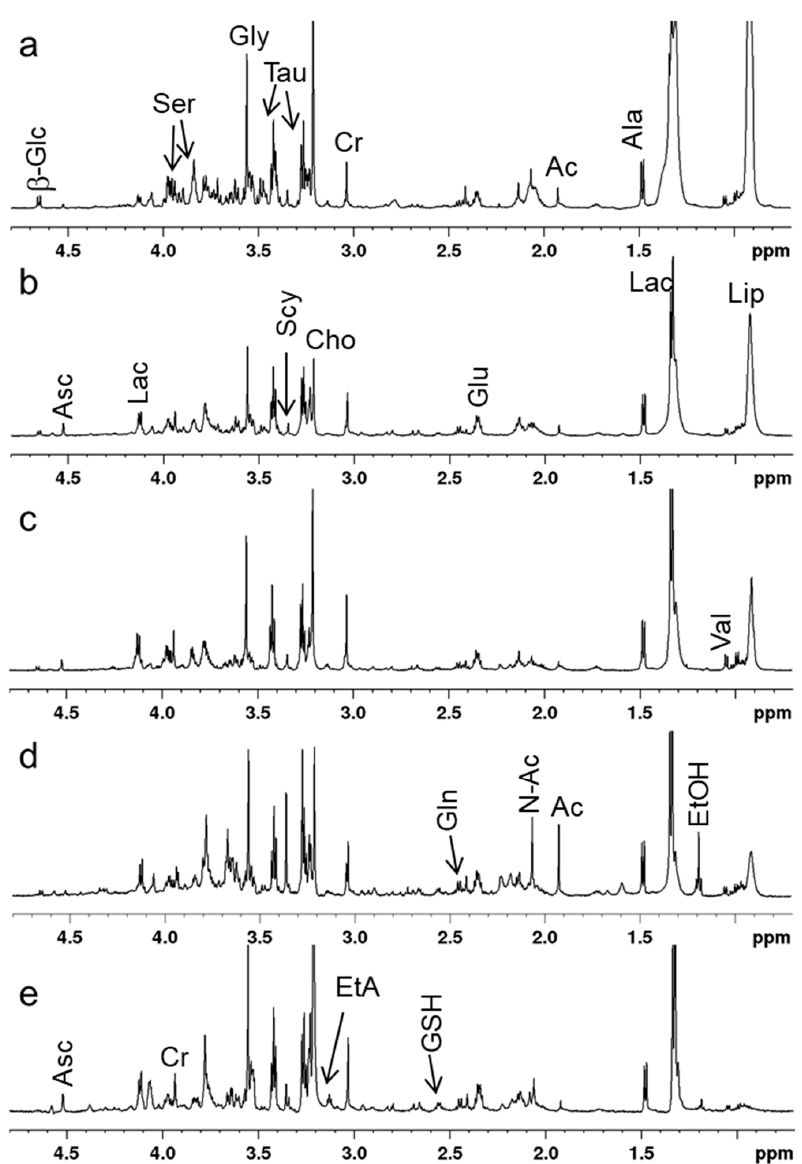
Figure 1. Representative 1D 1 H Carr–Purcell–Meiboom–Gill (CPMG) high-resolution 1 H magic